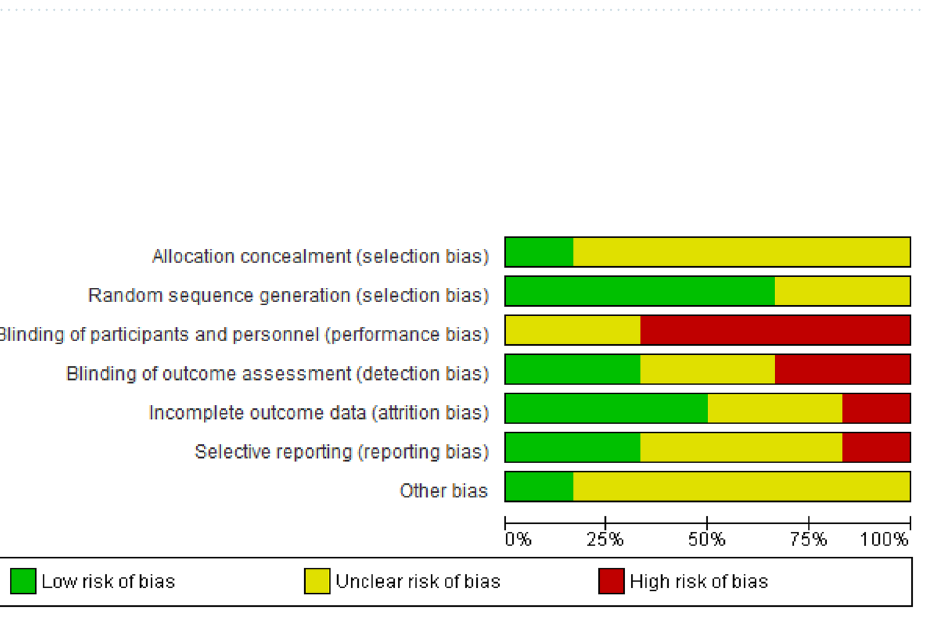
Figure 3. Risk of bias graph: review authors’ judgments on each risk of bias item presented as percentages across all included studies. Revman 5. https:// train ing. cochr ane. org/ online- learn ing/ core- softw are- cochr ane- revie ws/